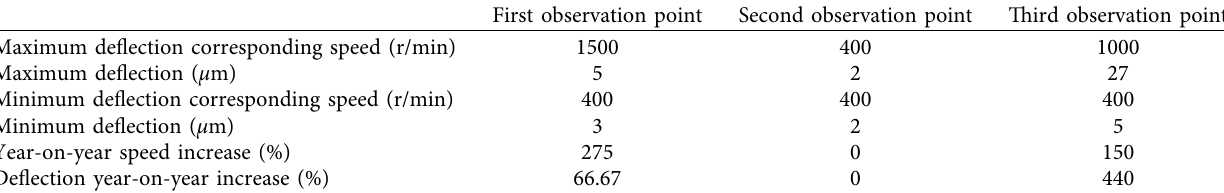
Table 16: Data summary of span-suspension ratio of